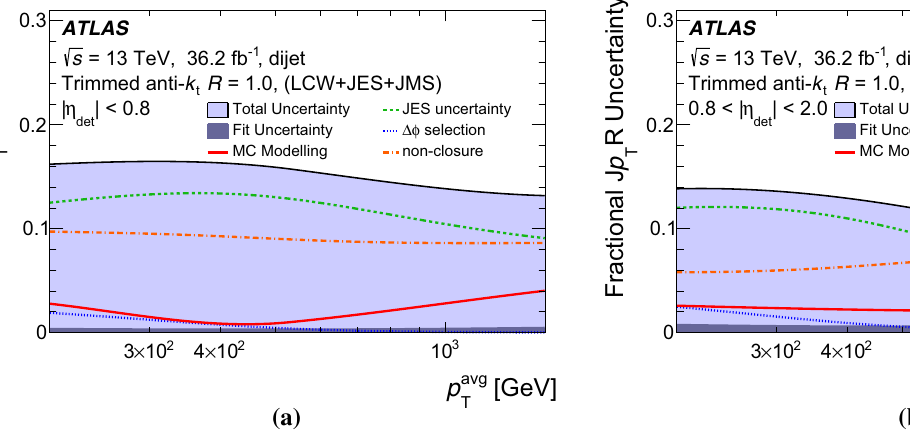
using the in situ technique for an average of three simulations and their envelope is also shown as a dark band. Inconsistencies between the resolution determined using the in situ technique and of the resolution determined from the response in simulation by matching particle-level jets to reco-level jets (light dotted line) are taken as an additional uncer- tainty in the measurement. The lines shown are obtained by smoothing a binned representation of these uncertainties using a sliding Gaussian kernel